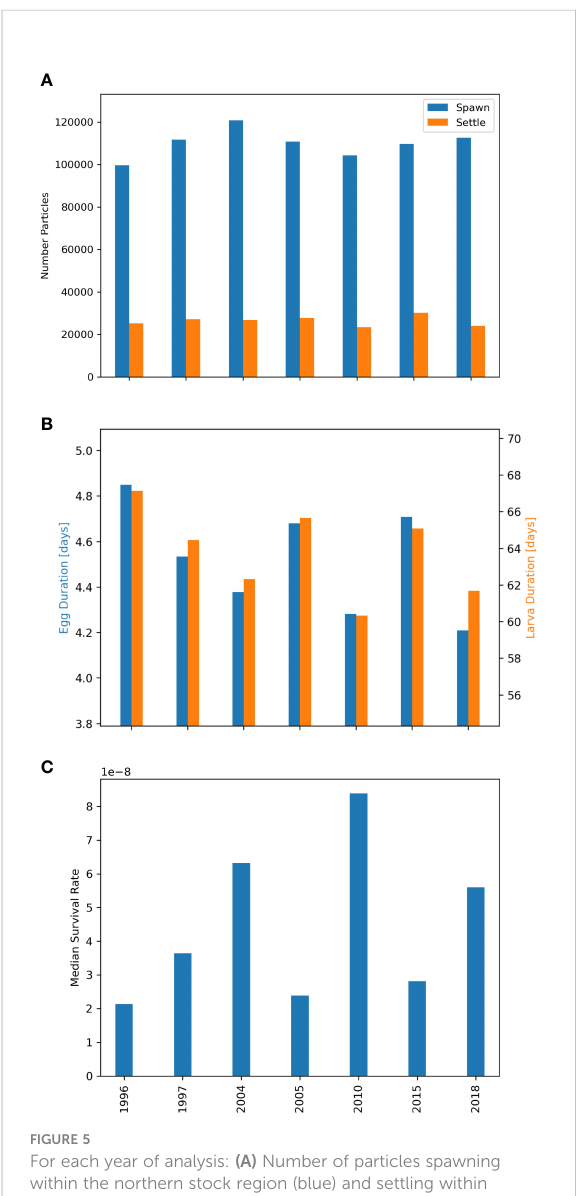
FIGURE 5 For each year of analysis: (A) Number of particles spawning within the northern stock region (blue) and settling within coastal ICES rectangles (orange); (B) Mean egg duration (blue) and larval duration (orange) [days], over the total number of settled particles; (C) Average survival rate (proportion of particles/eggs that survive, Equation 4), calculated as median across all settling